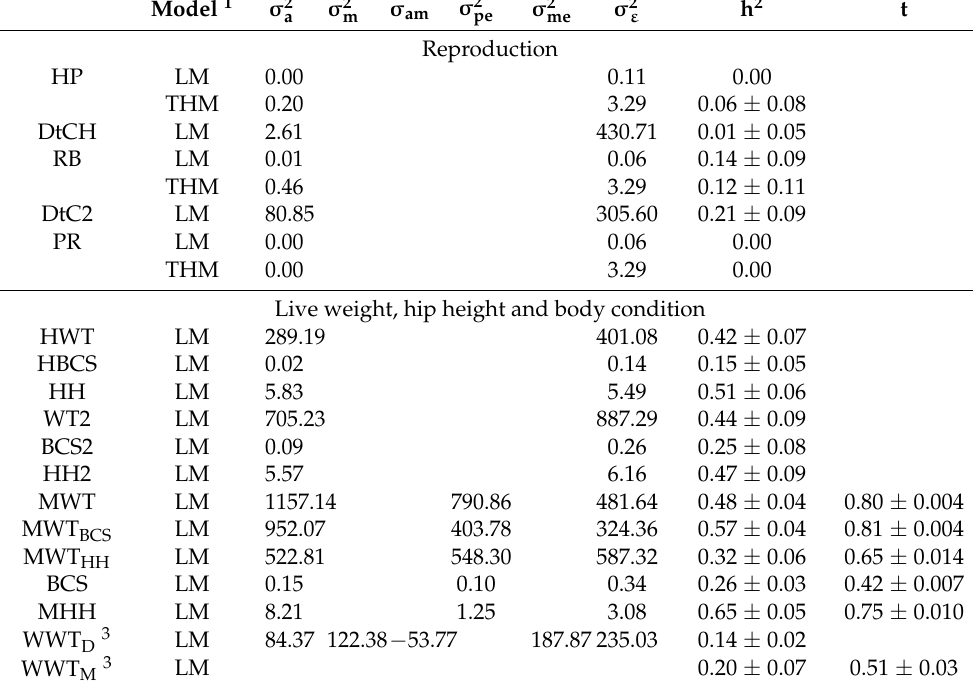
Table 4. (Co)variance components ( σ 2 a = additive genetic variance, σ 2 m = maternal genetic variance, σ σ 2 σ 2 am = direct-maternal genetic covariance, pe = permanent environmental variance, me = maternal environmental variance, σ 2 ε = residual variance), heritabilities (h 2 ± SE) and repeatabilities (t ± SE) from univariate animal models for maternal performance traits in New Zealand beef